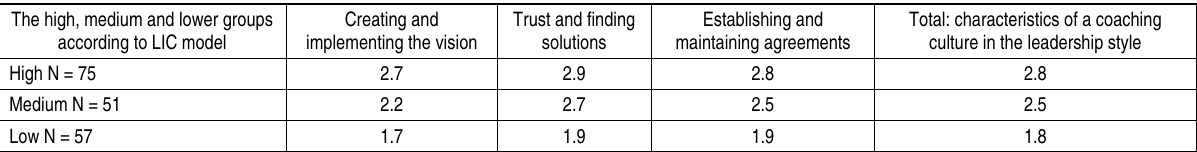
Table 8. Characteristics of a coaching culture in the leadership style (based on the 3C model) in